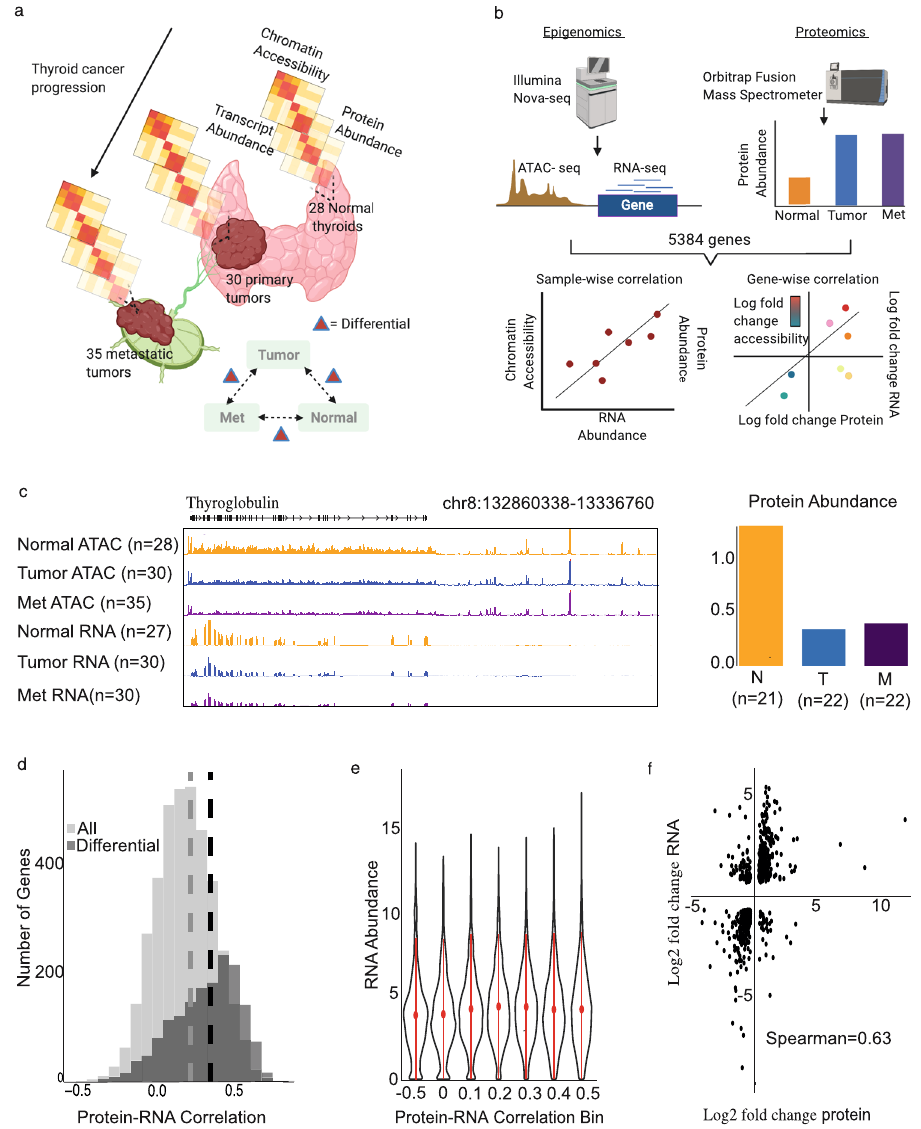
Fig. 1 Integrative multi-omic analysis of thyroid cancer cohort. a Cohort description, 93 samples of patient-matched samples of lymph-node metastases, primary thyroid tumors, and adjacent normal thyroid were assayed. Three omics are integrated to pro fi le chromatin accessibility, transcript abundances, and protein abundance. b Analytical framework, assay for transposase-accessible chromatin using sequencing (ATAC-seq), RNA-seq, and proteomics resulted in measurements for 5384 genes, which were used in correlation analyses across omics. c Visualization of the omic data for thyroglobulin ( TG ). Biologically independent tissue chunks from each disease stage (i.e., normal, tumor, and met) are averaged to produce the signal plots. d Distribution of protein – RNA correlation comparing all genes vs differentially expressed genes. e Distribution of RNA abundance for bins of protein – RNA correlations. f Gene-wise correlation of differentially expressed genes at the RNA level and differentially expressed proteins across all pairwise